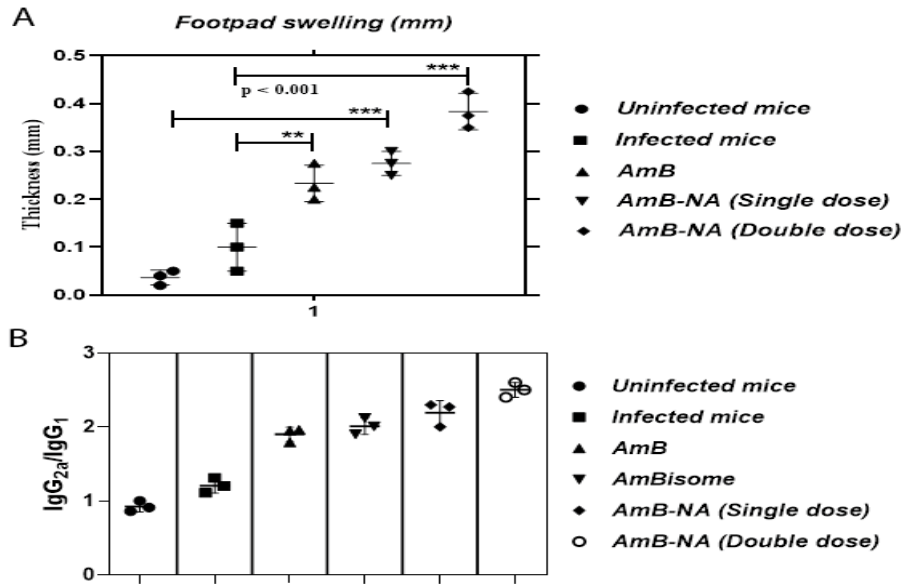
Figure 7. Immunomodulatory potential of the AmB-NA in the L. donovani-infected BALB/c mice. The L. donovani -infected animals were treated with various as-synthesized AmB-NA formulations following a published protocol described in the method. The splenocytes of the cured animals were isolated after 4-week post-treatment as described in the method. ( A ) DTH response evoked in the immunized animal post-treatment with various forms of AmB. Footpad swelling was considered as a parameter to determine the as-generated cell-mediated immune response in the treated BALB/c mice. The treatments (50 µg SLA) were applied in a footpad, and the magnitude of DTH was assessed post 48 h. SLA was inoculated in the uninfected group, infected, untreated, and variously treated groups (AmB-NA (single dose), AmB-NA (double dose), and AmB). ( B ) Four-week post-treatment, blood from various experimental groups was collected to separate sera. ELISA was performed to evaluate antibody levels. IgG2a/IgG1 isotype ratios for AmB and AmB-NA single dose-treated mice were 1.9 and 2.1, respectively, thus proving AmB-NA to have better therapeutic efficacy against VL. Data represented means ± SE for mice per group and are representative of three independent experiments with similar results. ** p < 0.01, *** p < 0.001.